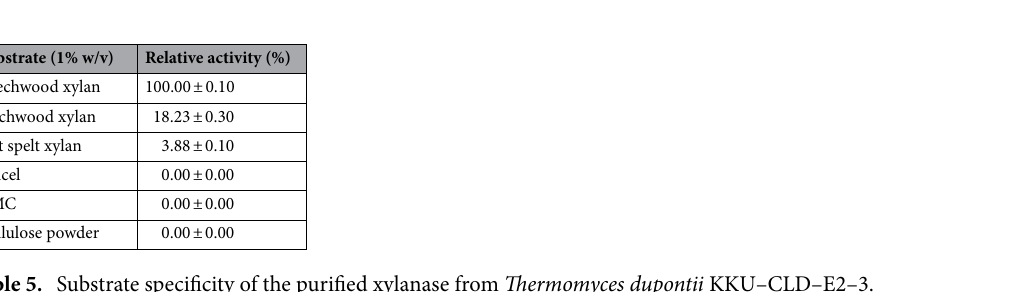
Table 5. Substrate specificity of the purified xylanase from Thermomyces dupontii KKU–CLD–E2–3.